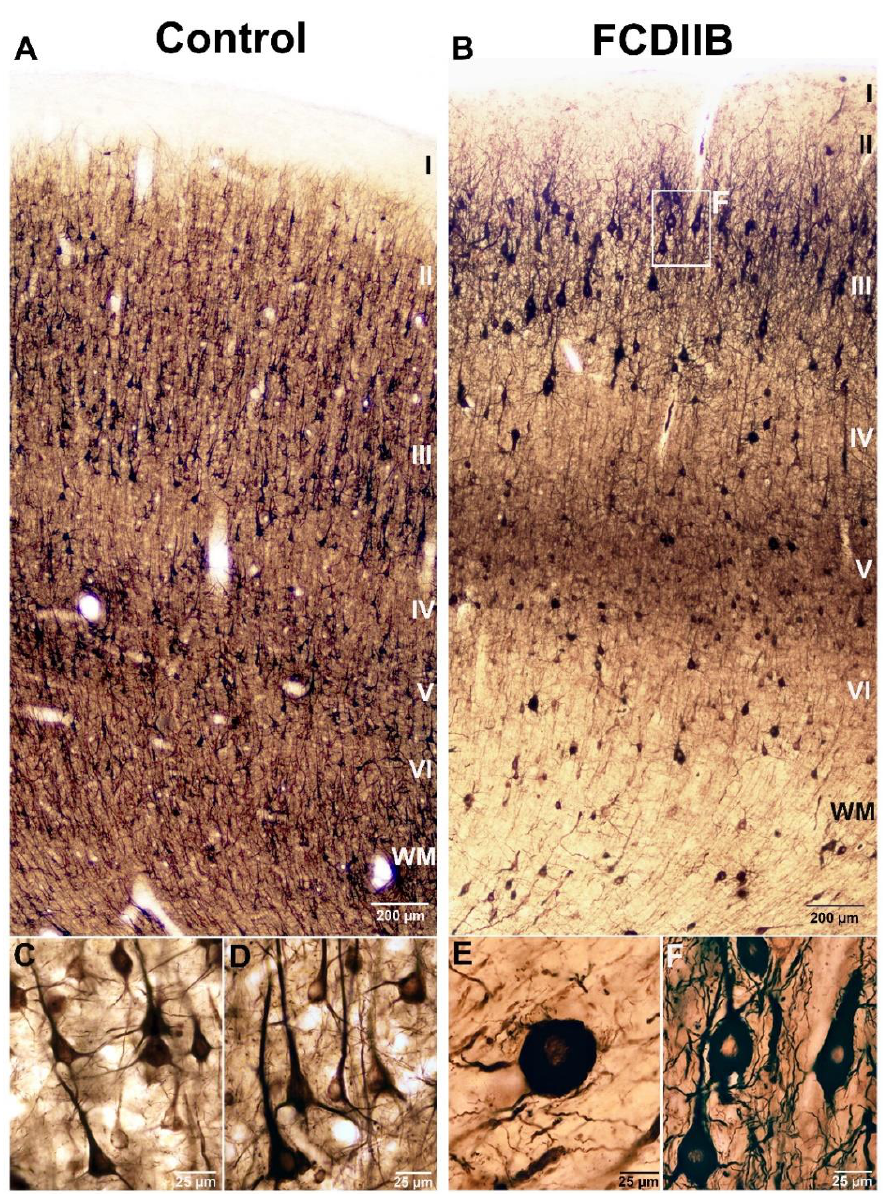
Figure 1. Non-phosphorylated neurofilament H (SMI32)-immunopositive elements in a control sample ( A , C , D ) and in an epileptic patient with FCDIIB in frontal cortex ( B , E , F ). SMI32-immunostaining labels principal cells with high specificity. (( A , D) : the cortical layers are marked by Roman numerals). Control principal cells from layers III and V are shown in ( C , D ) panels, respectively. There are numerous dysmorphic neurons in the FCD cortex (( B , F ): layer III). The giant neurons have abnormally thick dendrites and thin, irregular, short processes ( F ). Presumable balloon cells are visible in the white matter and layer VI ( B , E ). Balloon cells have only a few, atrophic processes and large, balloon-like rounded cell bodies ( E ). Scales: ( A , B ): 200 µm; ( C – F ): 25 µm .